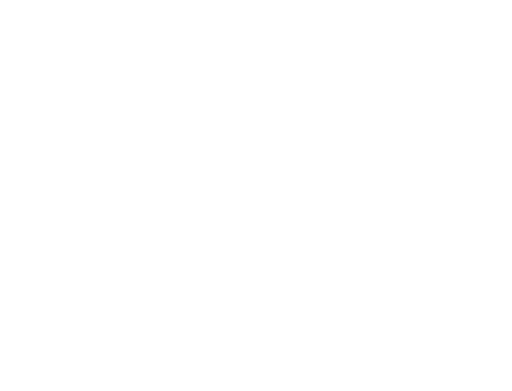
Figure 2. First-order diffraction efficiency for multistep blazed gratings. Nonlinear phase levels below N = 16 were chosen from the available levels such that the phase profile followed the same trend as the device being tested and had similar R 2 values.